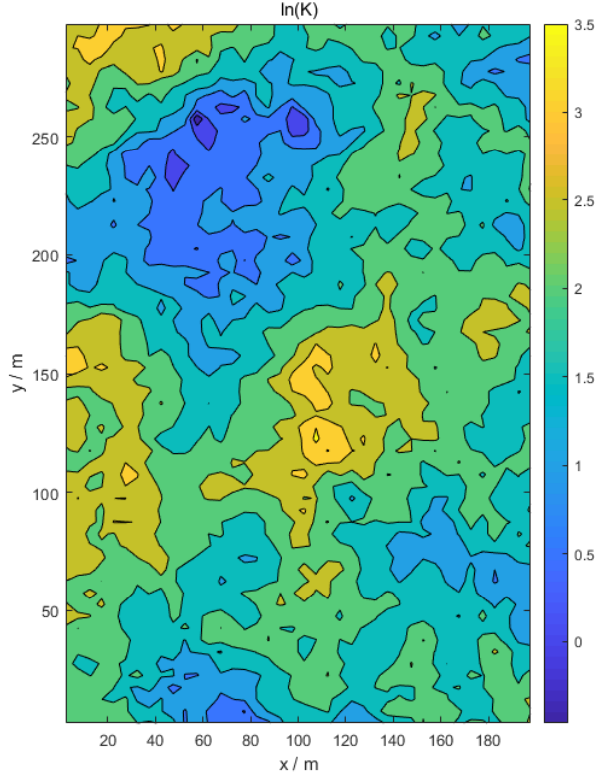
Figure 6. The true hydraulic conductivity field for the hypothetical aquifer.